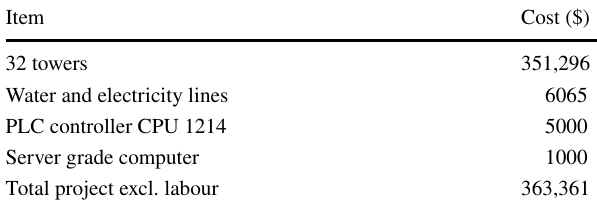
Table 3 Total cost of the